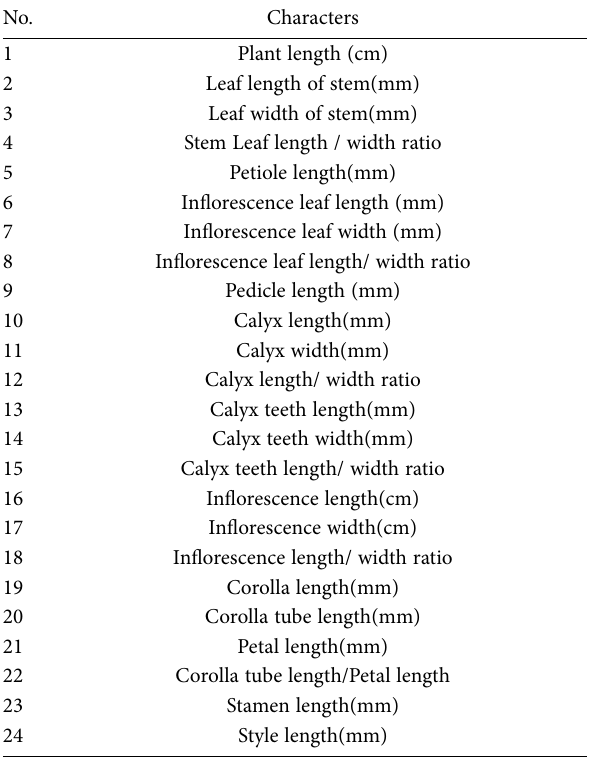
Table 3. Quantitative morphological characters studied in Z. clino- podioides populations.